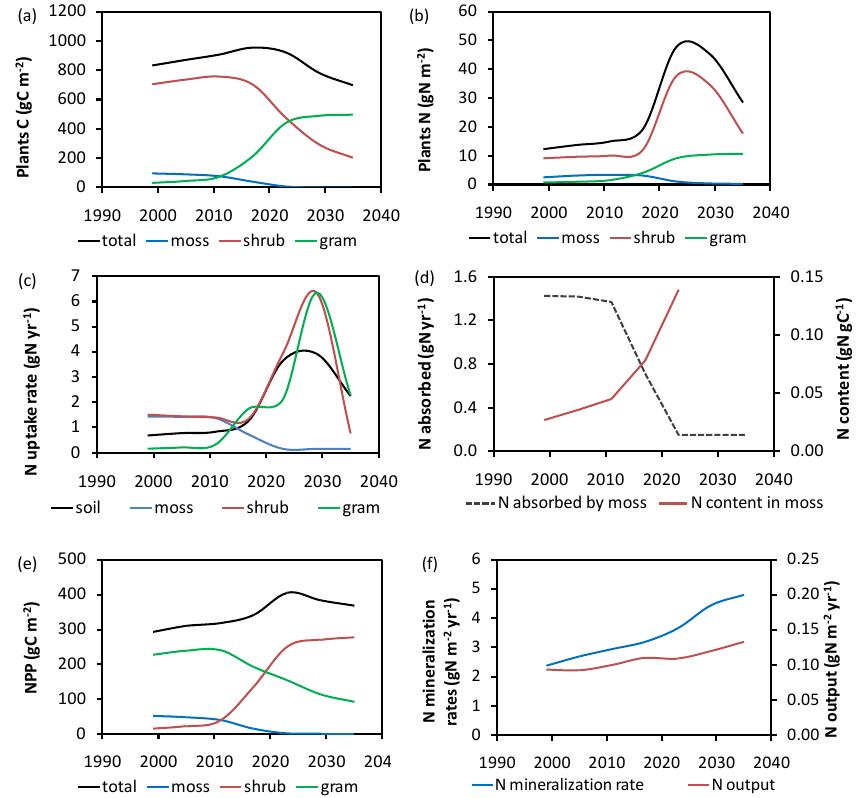
Figure 11. Simulated C pools (a), N pools (b) and NPP (e) in plants and PFTs, N uptake rate by in plants and sequestration rate in peat (c), N absorbed by moss and N content in mosses (d), N mineralization rate and N output from peat (f) at annual wet N deposition of 1.5g N m -2 yr -1 from 1999 to 2039.